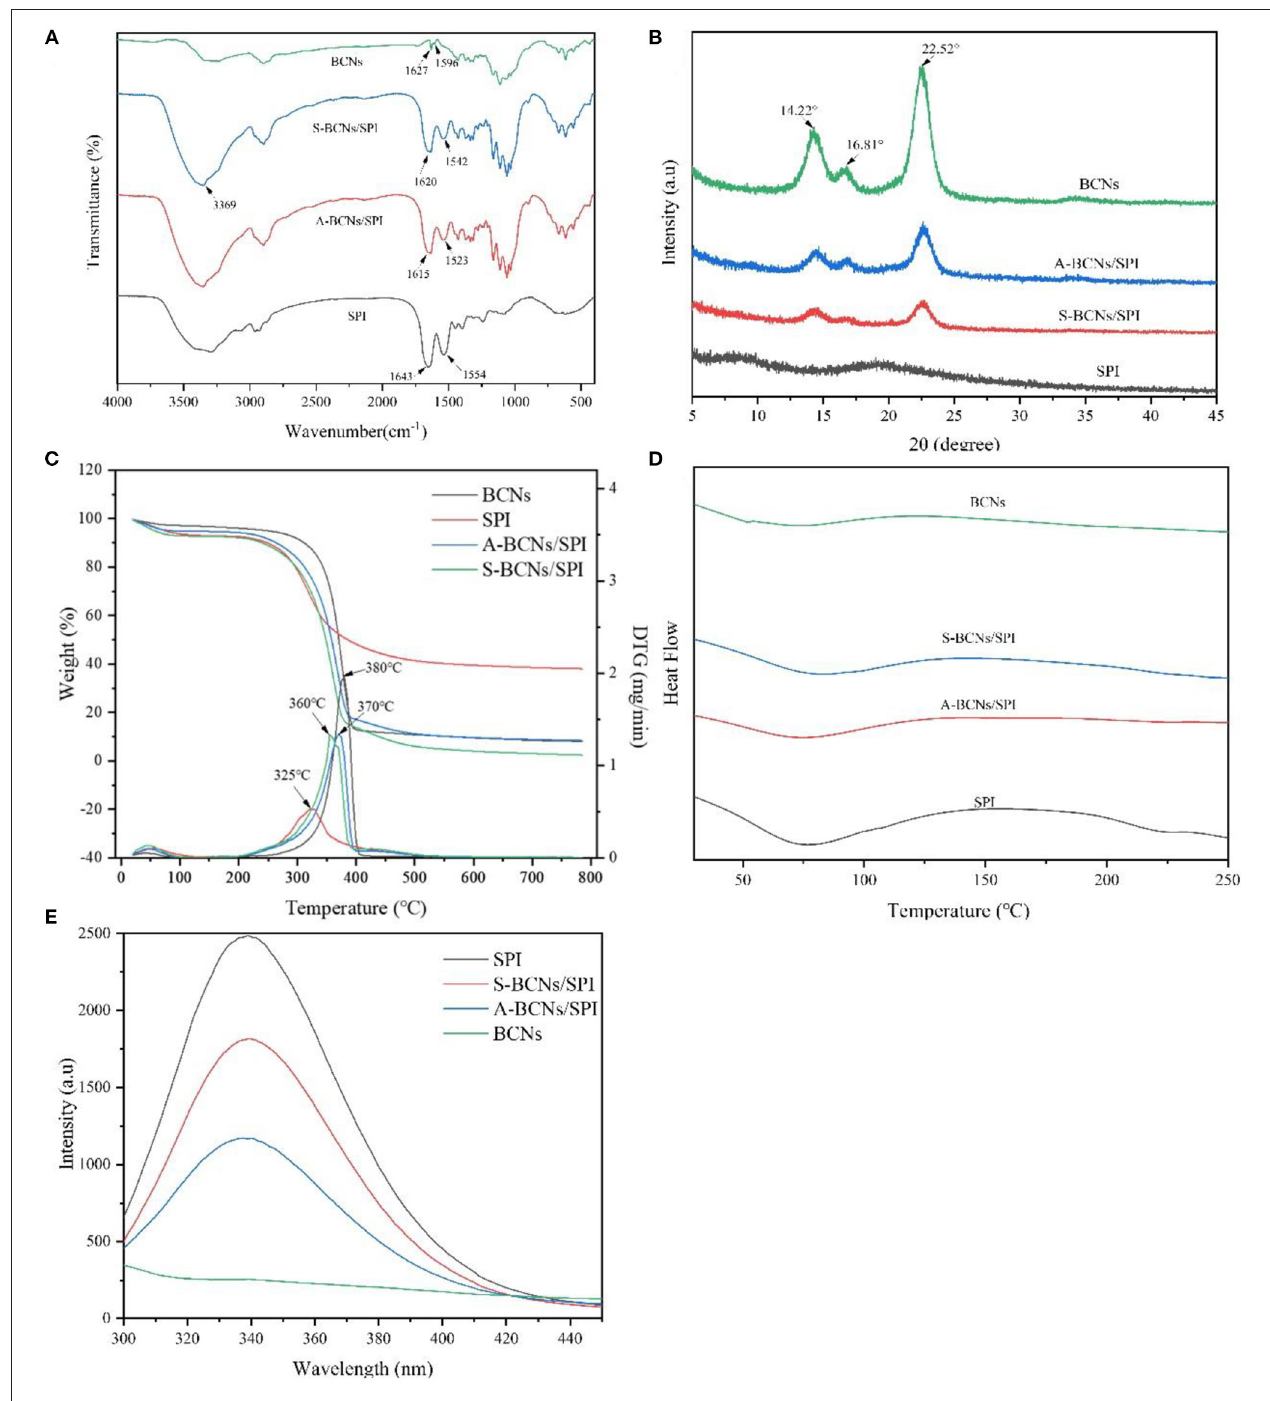
FIGURE 2 | Fourier transform IR (FT-IR) (A) , x-ray diffraction (XRD) (B) , thermogravimetric analysis (TGA) (C) , differential scanning calorimetry (DSC) (D) , and fluorescence spectrums (E) of SPI, BCNs, and BCNs/SPI colloidal particles prepared by using different self-assembly methods.